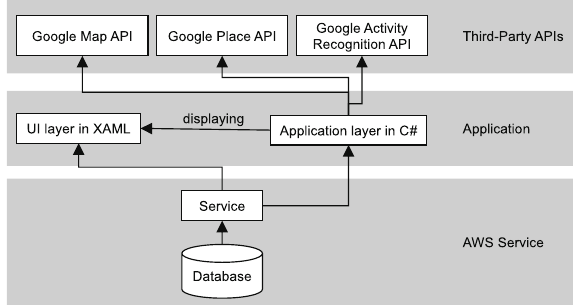
Figure 2. Architecture of MiniHongo.